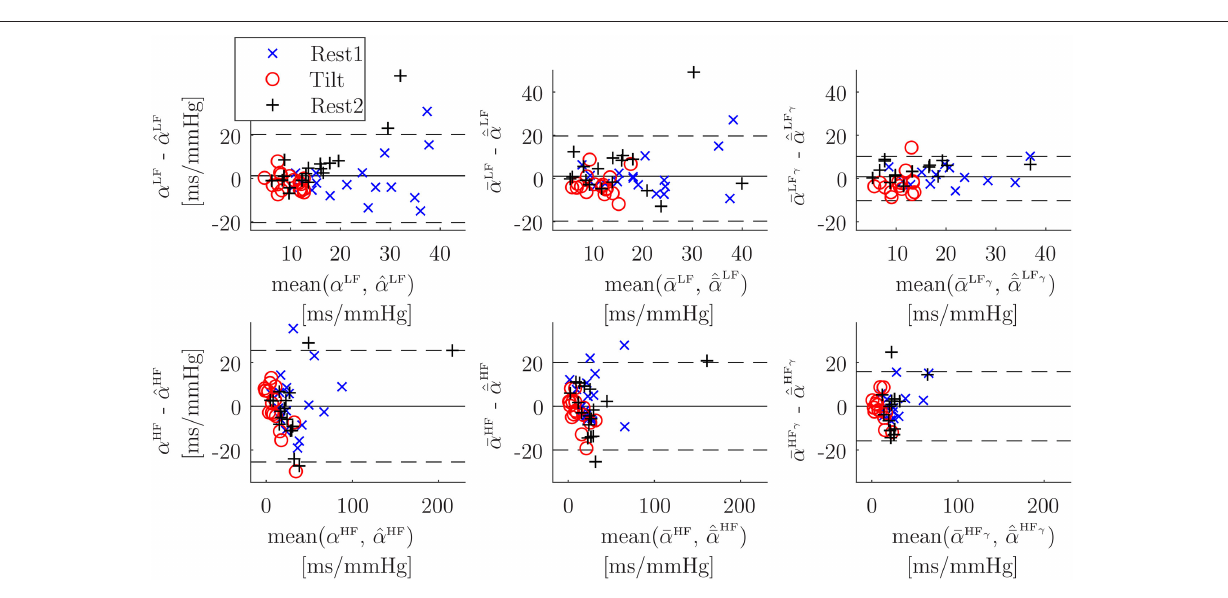
FIGURE 7 | Bland-Altman plots of α vs. its multiple-linear-regression-based combination of surrogates ˆ α (Welch-periodogram approach, first column), of ¯ α vs. its multiple-linear-regression-based combination of surrogates ˆ¯ α (time-frequency approach, second column), and of ¯ α γ vs. its multiple-linear-regression-based combination of surrogates ˆ¯ α γ (time-frequency coherence approach, third column). Note that scales are not the same for LF band (first row) than for HF band (second